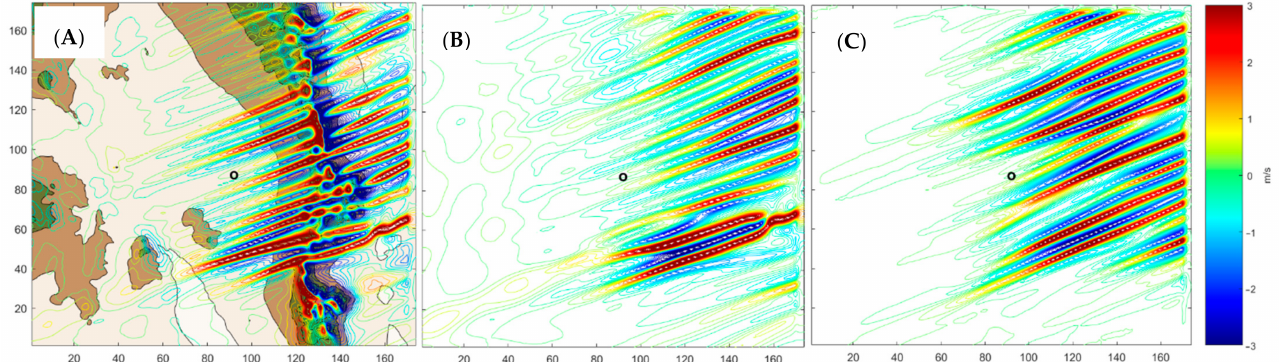
Figure 16. WRF w velocity horizontal cross section at 1 km agl JER, 2100 UTC on 12 April 2018. ( A ) Unaltered topography. ( B ) Local topography removed. ( C ) Regional topography removed. Black circle indicates MSA Tower